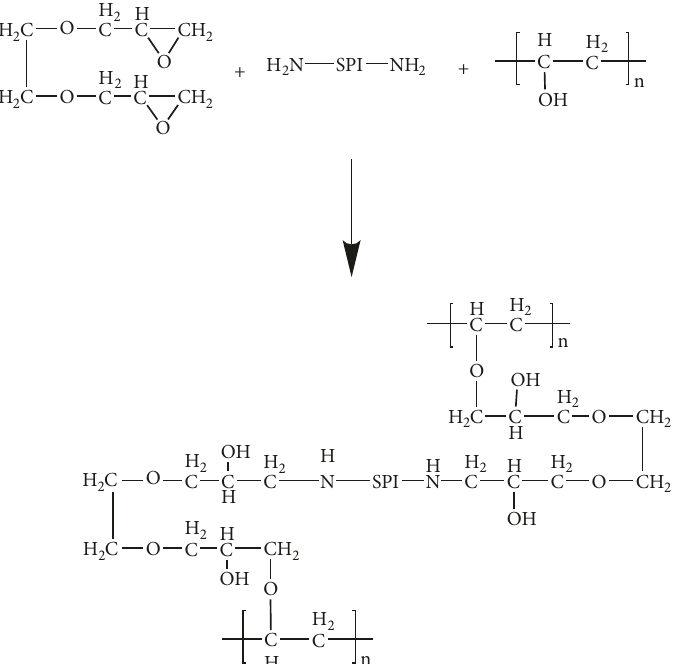
Figure 1: The interaction among EGDE, SF, and